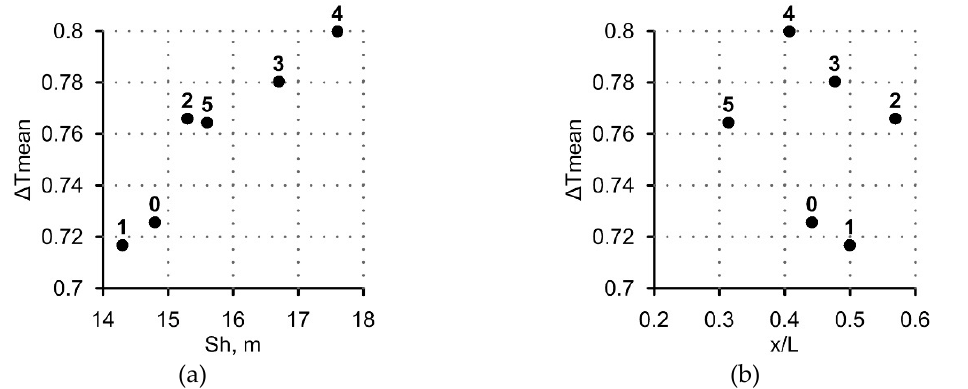
Figure 8. Dependence of ( a ) shoreline retreat (Sh, m) and ( b ) the relative distance of seaward sediment transport (x/L) on the relative change in the mean wave period ( Δ Tmean, s) occurring during wave transformation over a barred profile (620–820 m, see Figure 4). L is the wavelength calculated for deep-water conditions, and x is the distance of maximal sediment transportation away from the shore.